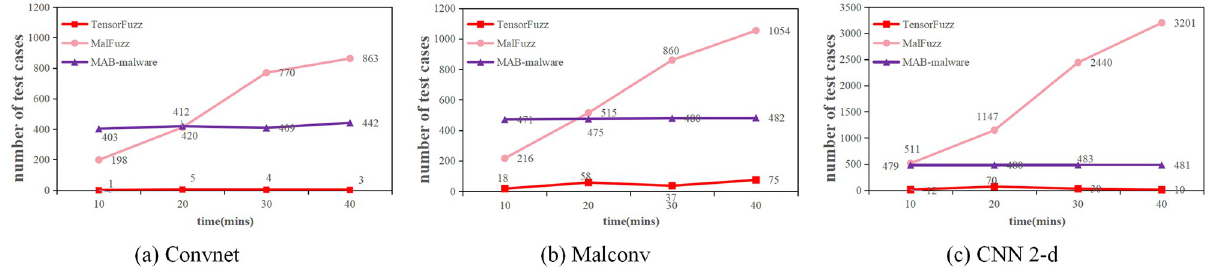
Fig 6. Executable test cases with different mutation